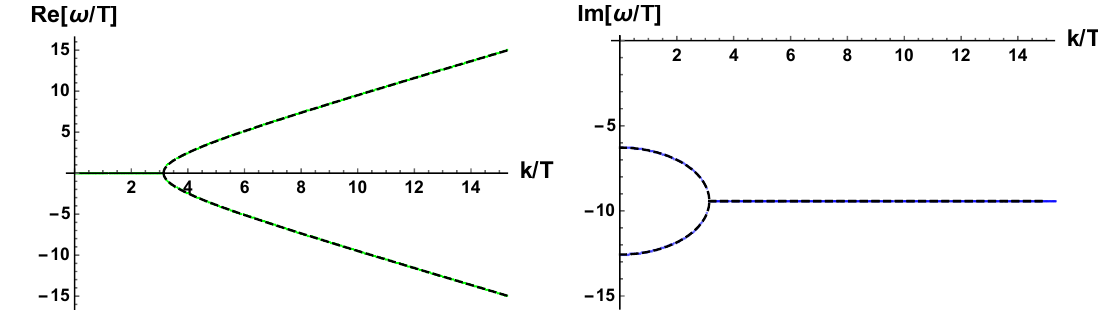
Figure 11 . A comparison between the analytic formula (4.20) obtained in [48] and the QNMs spectrum computed numerically at the self dual point (cid:15) = 0. The agreement is